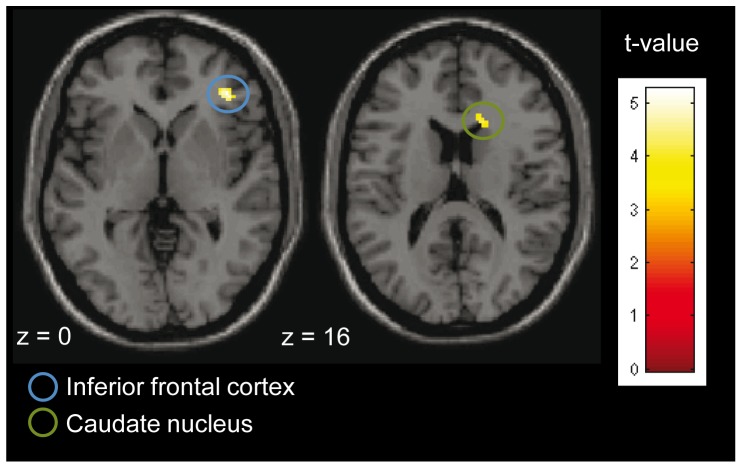
Activation in response to body odors in HO vs. LO participants.HO participants show activation within the right inferior frontal cortex and within the right caudate nucleus (k≥20; p<0.001). For visualization a normalized template provided by SPM 8 software (single_subj_T1.nii) was used.